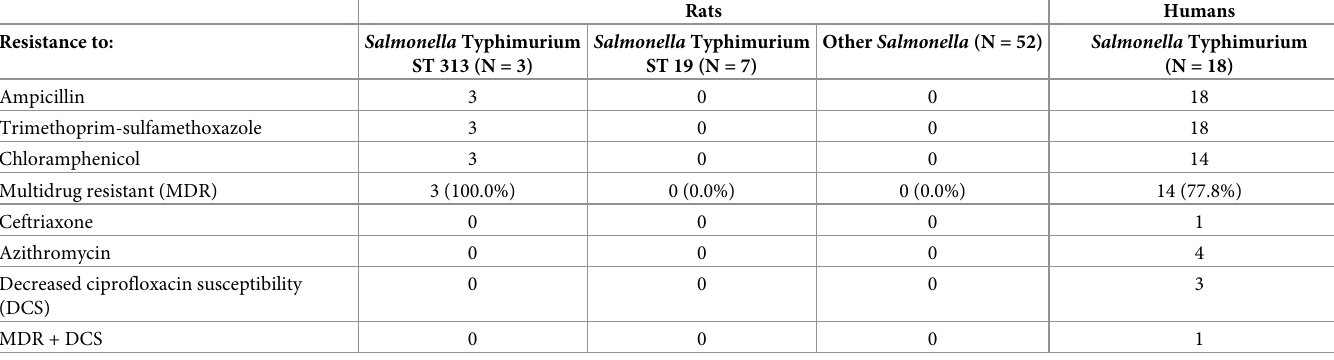
Table 4. Antimicrobial resistance profiles of Salmonella Typhimurium isolates from rats and humans (blood cultures). Data present numbers (%) of resistant iso- lates. Only the first isolate per serotype and rat is listed. MDR: multidrug resistant, i . e . resistant to ampicillin, trimethoprim-sulfamethoxazole and chloramphenicol. DCS = decreased ciprofloxacin susceptibility, i . e . ciprofloxacin MIC-value > 0.064 mg/L and < 1 mg/L. Rats Humans Resistance to: Salmonella Typhimurium Other Salmonella (N = 52) Salmonella Typhimurium Salmonella Typhimurium ST 313 (N = 3) ST 19 (N = 7) (N = 18) Ampicillin 3 0 0 18 Trimethoprim-sulfamethoxazole 3 0 0 Chloramphenicol Multidrug resistant (MDR) Ceftriaxone Azithromycin Decreased ciprofloxacin susceptibility